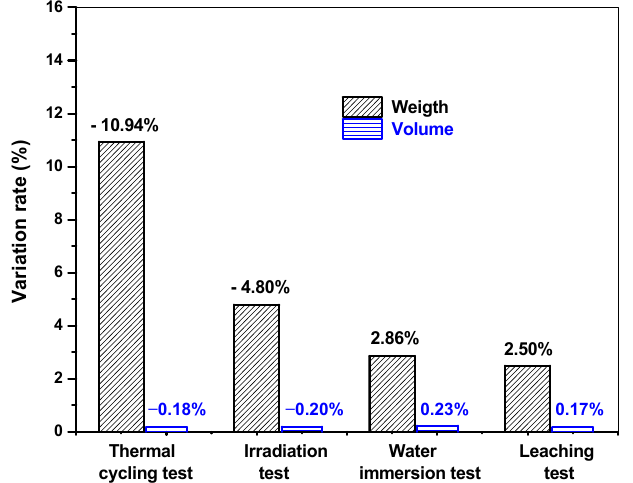
Figure 7. Changes in the weight and volume of the representative samples before and after each test.